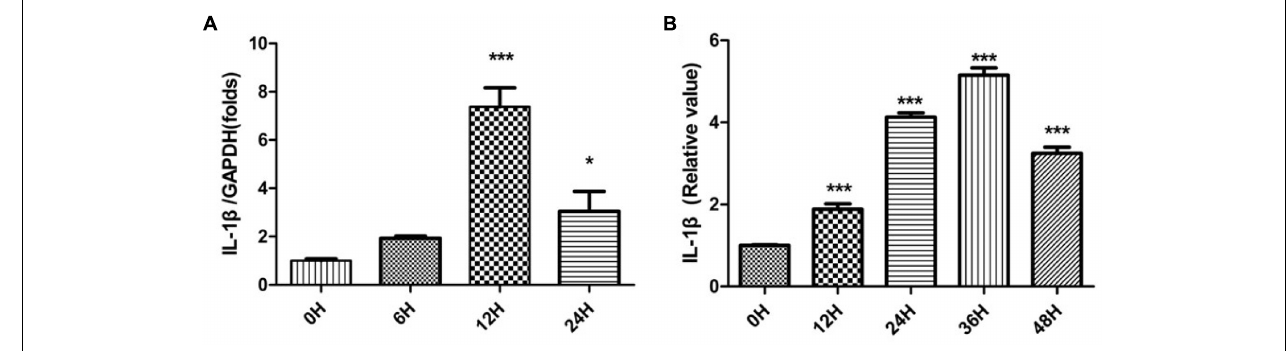
FIGURE 1 | IL-1 β mRNA expression and IL-1 β protein production. The relative quantification of IL-1 β mRNA was performed by qPCR (A) and IL-1 β protein levels were determined by ELISA (B) in SCs. The control group is labeled as 0 h. SCs harvested from SNs at different times were compared to the control group. ∗ p < 0.05, ∗∗∗ p <